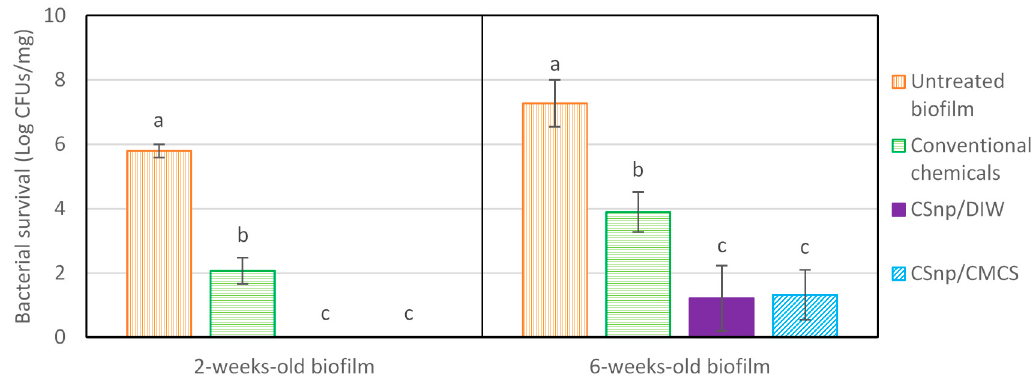
Figure 4. Microbiological evaluation of antibacterial efficacy of CSnp formulations versus conventional chemicals on 2- and 6-week-old E. faecalis biofilm aliquoted following pulverization and bacterial enrichment. Different characters above bars indicate statistically significant difference between the groups at each biofilm age ( p < 0.001).